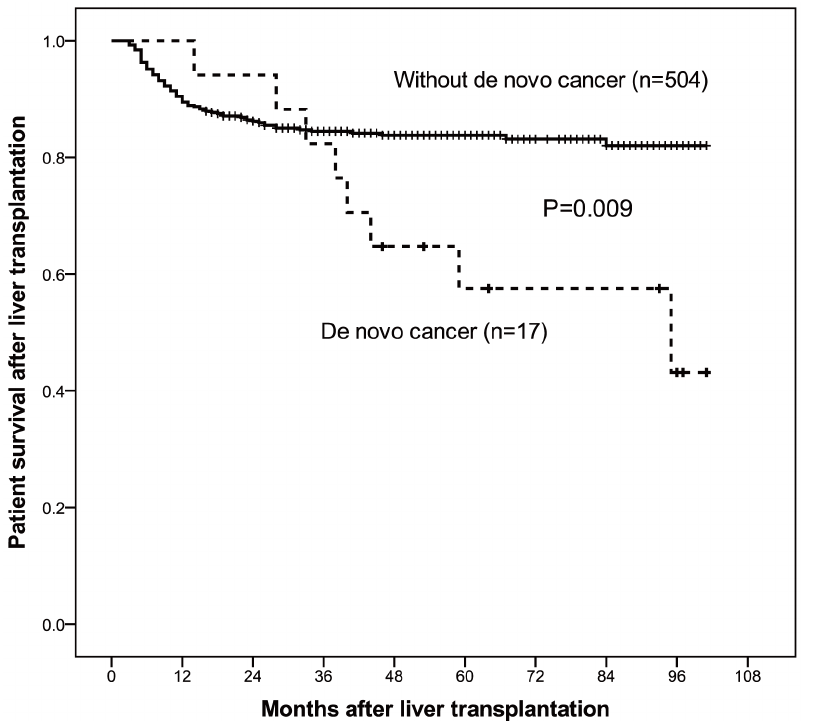
Figure 3. Kaaplan-Meier survival analysis for patients with and without denovo cancer after liver transplantation. Patients without de novo cancer who died of tumor recurrence were excluded from comparison.